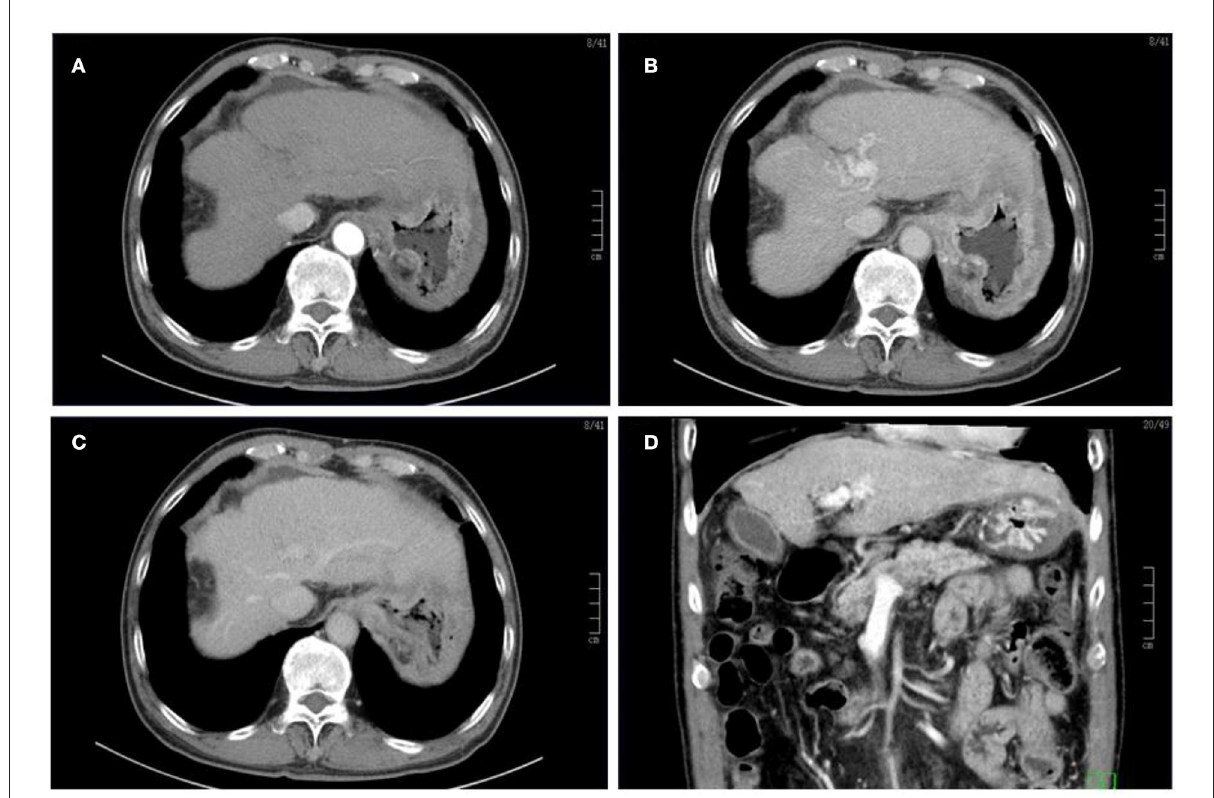
FIGURE4 Following the initial presentation, enhanced CT was obtained 2 years later, which revealed that the mass on the left liver lobe and the portal vein-filling defect had disappeared. Note that the intraperitoneal effusion had been also absorbed (A–D)